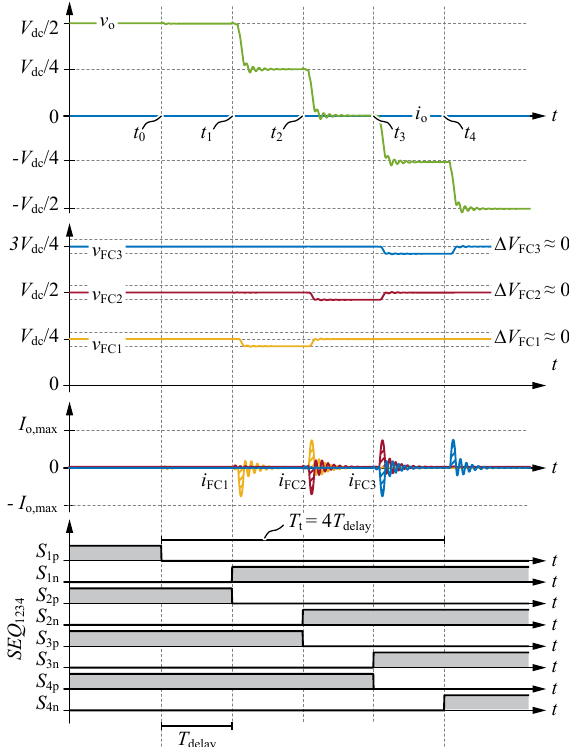
Figure 4. Simulation results for the 5L-FCC in configuration 1 (cid:13) with zero output current during the Q2L transition with negative slope of v o : Zero net charge increments of the FCs